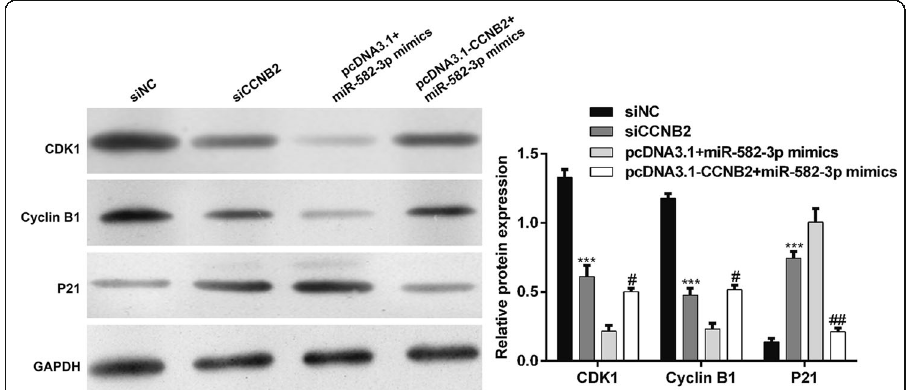
Fig. 5 MiR-582 – 3p targeted CCNB2 and suppressed G2/M phase arrest-related molecules. THP-1 cells were transfected with siCCNB2, siNC, miR-582 – 3p mimics + pcDNA3.1 or miR-582 – 3p mimics + pcDNA3.1-CCNB2. The protein levels of CDK1, cyclin B1 and P21 were determined using western blot. Data are presented as means ± SD from three independent experiments. *** p <0.001 vs. siNC; # p <0.05, ## p <0.01 vs. miR-582 – 3p mimics +